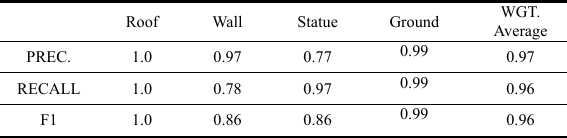
Table 2. Classification metrics at level 1 for NCS.